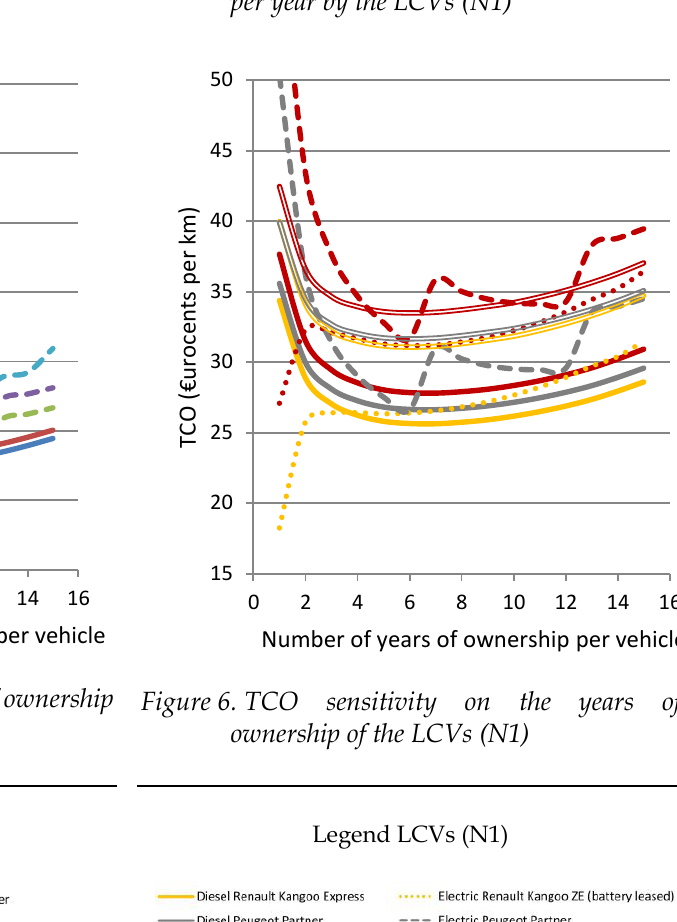
Figure 4. TCO sensitivity on the kilometres driven per year by the LCVs (N1)